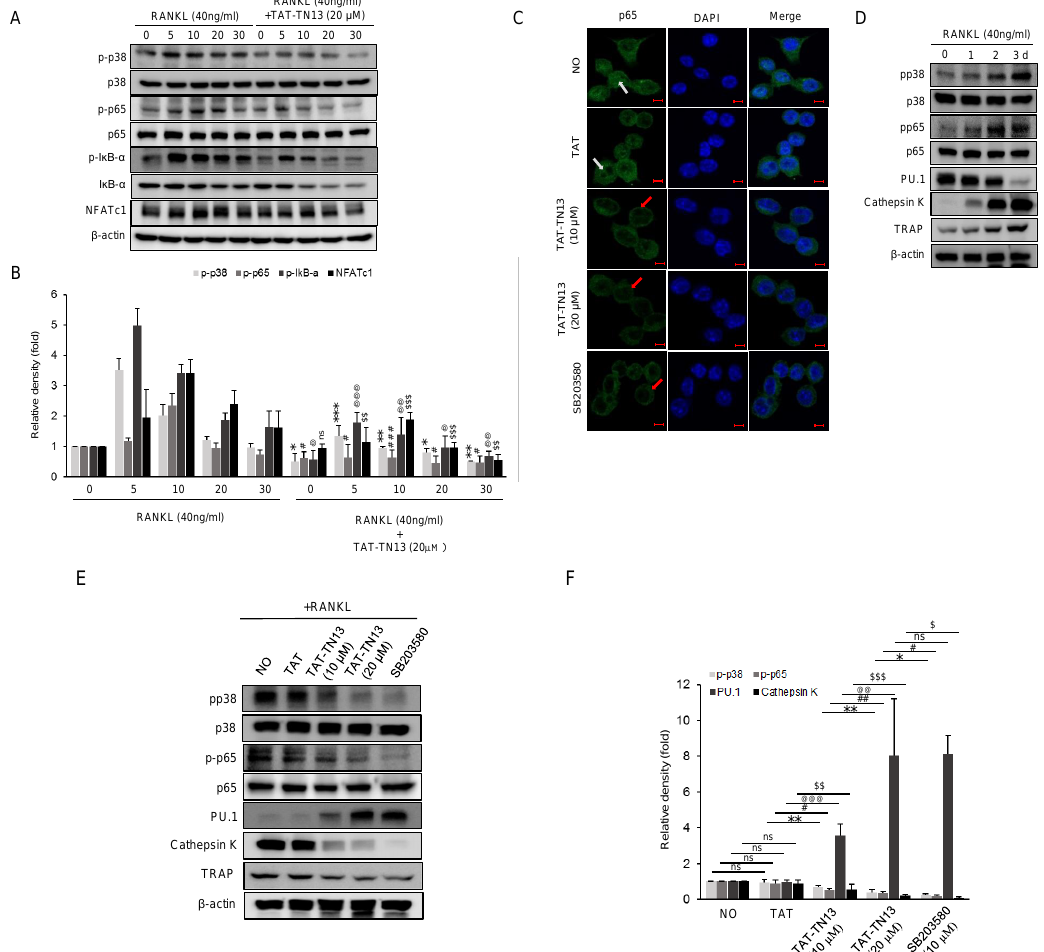
Figure 5. TAT-TN13 Inhibits NFATc1 activation by suppressing RANKL-induced phosphorylation of p65 in RAW 264.7 cells. ( A ) RAW 264.7 cells were pretreated in the presence or absence of TAT-TN13 and stimulated with RANKL (40 ng/mL) for the indicated times. Whole cell lysates were subjected to Western blot analysis with the indicated antibodies. ( B ) Statistical analysis of p-p38, p-p65, p-I κ B- α , and NFATc1 levels in ( A ). These experiments were repeated three times. ( C ) RAW 264.7 cells were analyzed by immunofluorescence microscopy for nuclear localization of p65. The cells were pretreated for 1 h with or without 20 µ M TAT-TN13 and then stimulated with RANKL for 30 min. The green color represents p65 staining, the blue color represents nuclei staining (scale bars: 5 µ m). Red arrow indicates the localization of p65 in the cytoplasm, and white arrow specifies the presence of p65 in the nucleus. ( D , E ) Expression of osteoclast-specific genes during RANKL-mediated osteoclastogenesis. RAW 264.7 cells were cultured with RANKL without TAT-TN13 for the indicated periods. Cells were cultured with RANKL in the presence or absence of TAT-TN13 for 3 days. Cell lysates were analyzed using Western blotting. The expression of phospho-p38, p38, phospho-p65, p65, PU1, Cathepsin k, TRAP and β -actin was evaluated. ( F ) Statistical analysis of p-p38, p-p65, PU.1, Cathepsin K, and TRAP levels in ( E ). These experiments were repeated three times. NO: control, which was not treated; TAT: treated control, which was treated with control peptide. The results are presented as the mean ± S.D of three independent experiments (* ,#,@,$ p < 0.05, ** ,##,@@,$$ p < 0.01, *** ,###,@@@,$$$ p < 0.001; n.s.: not